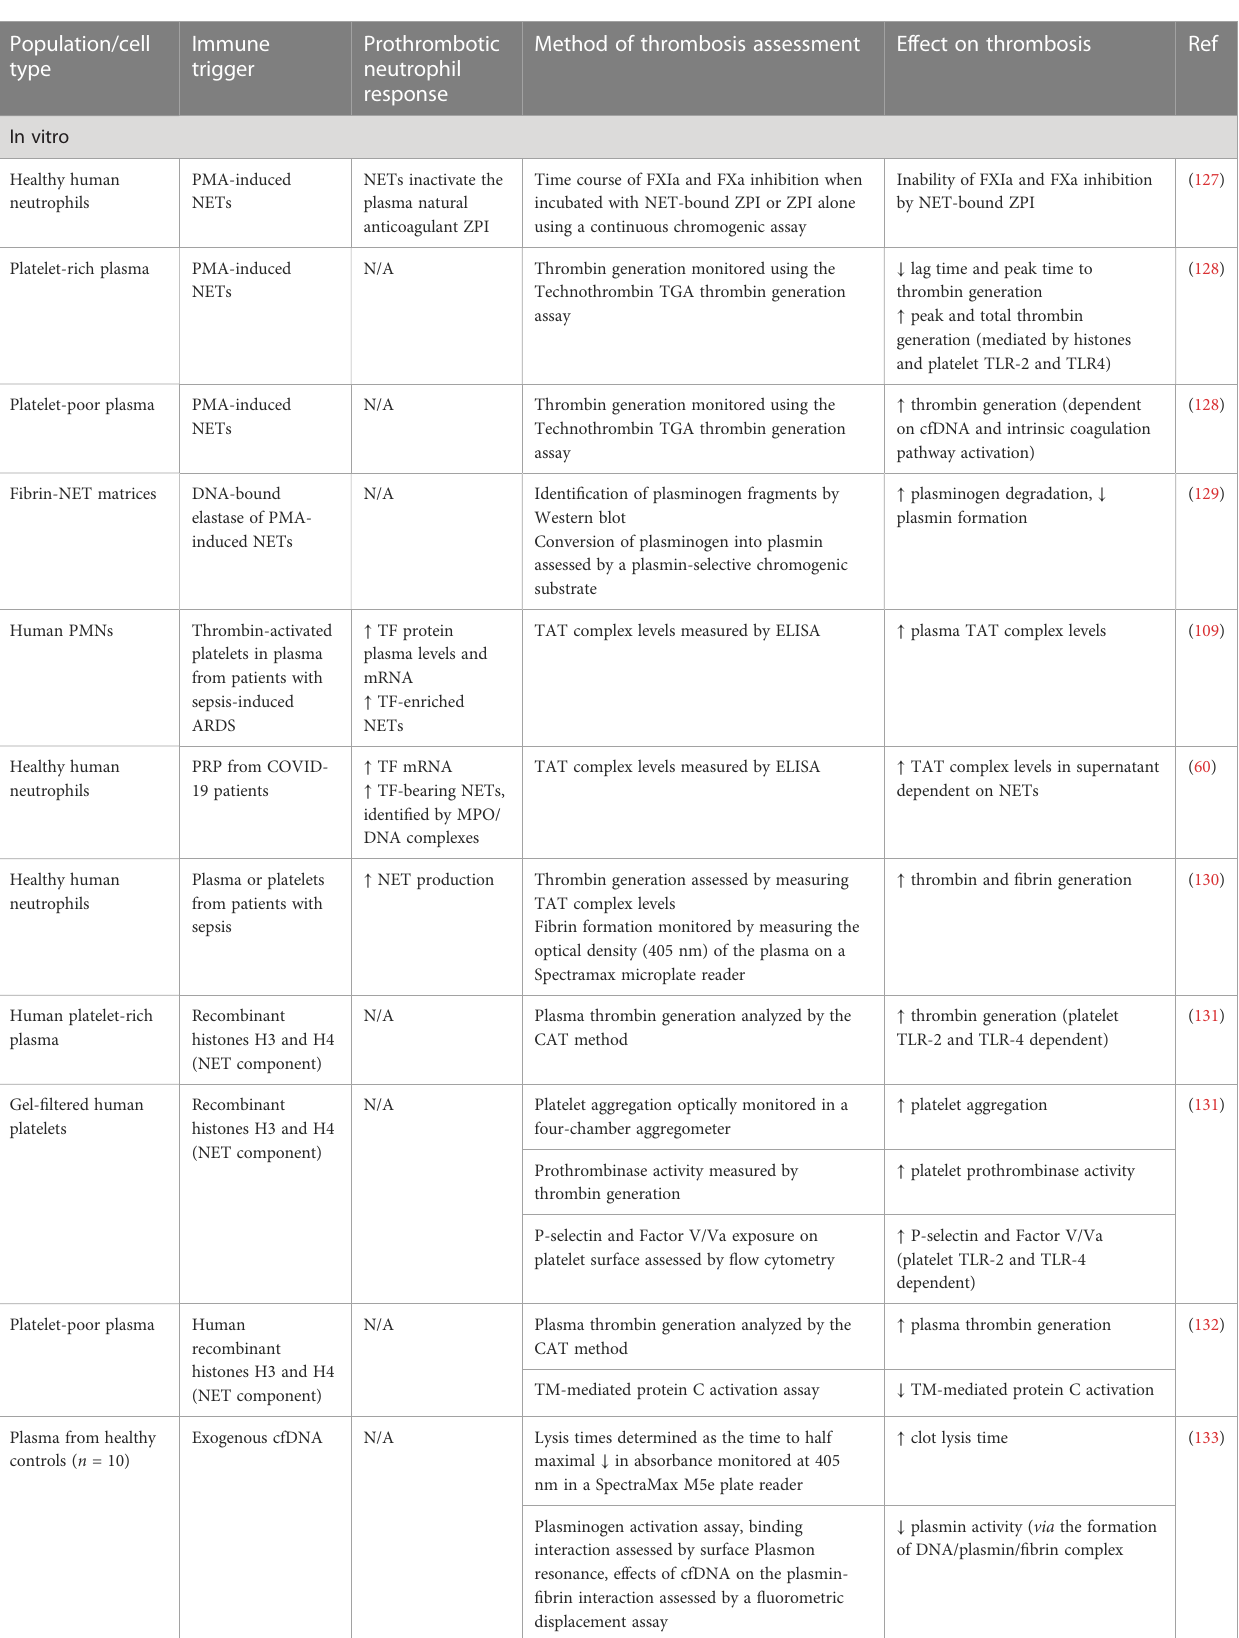
TABLE 3 Role of neutrophils in